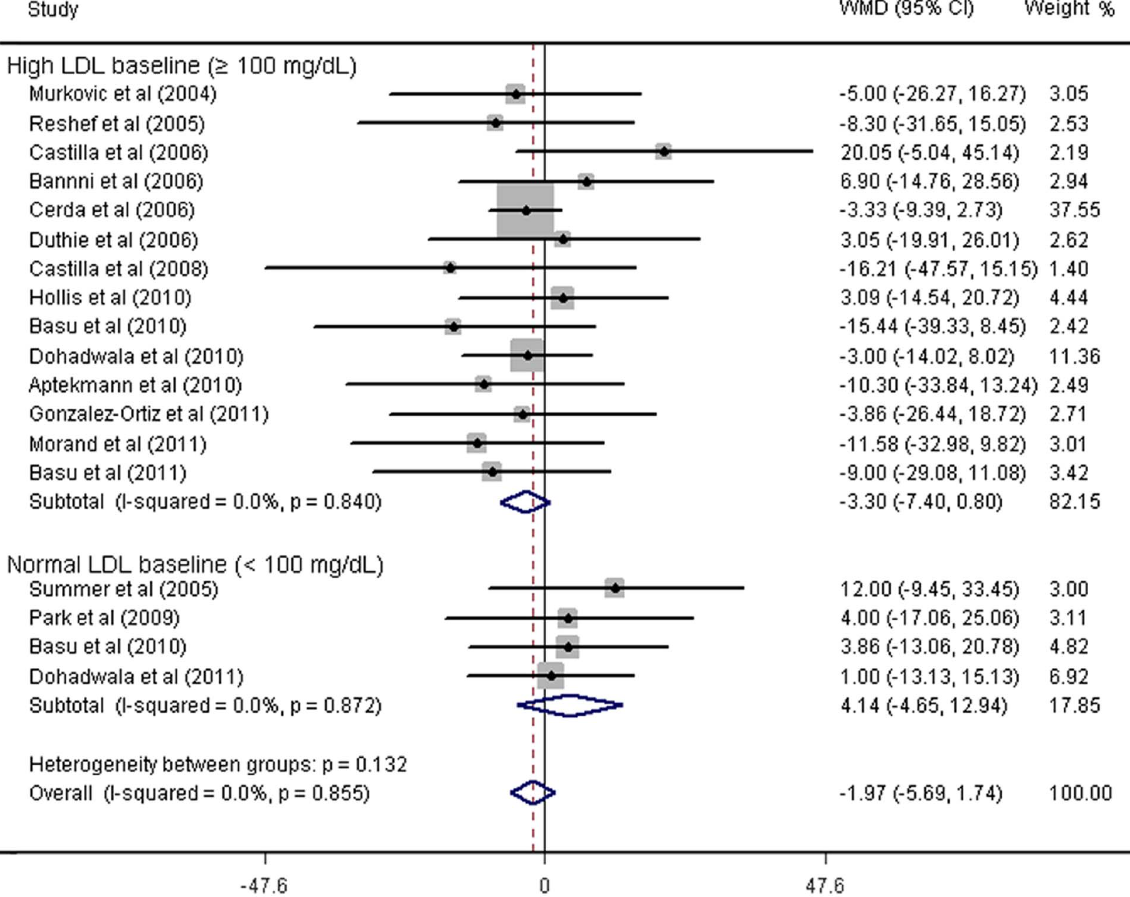
Figure 4. Meta-analysis of effects of fruit juice on low-density lipoprotein-cholesterol (LDL-C) concentrations. The result was obtained from a fixed-effects model. Sizes of data markers indicate the weight of each study in this analysis. The basis of classification of LDL-C is referred to the National Cholesterol Education Program guidelines, Adult Treatment Panel III. WMD, weighted mean difference.